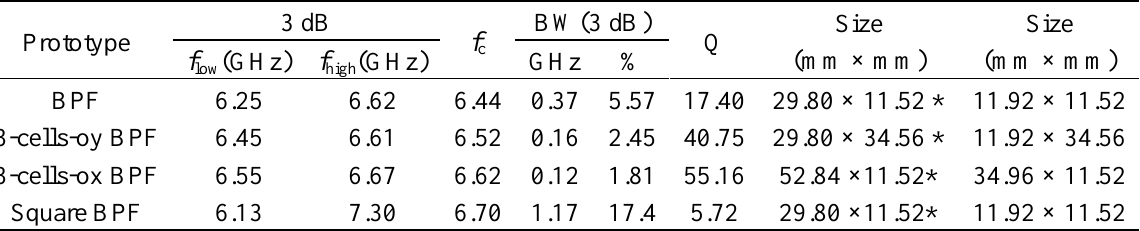
Table 1. Simulated band-pass filter quality factor.